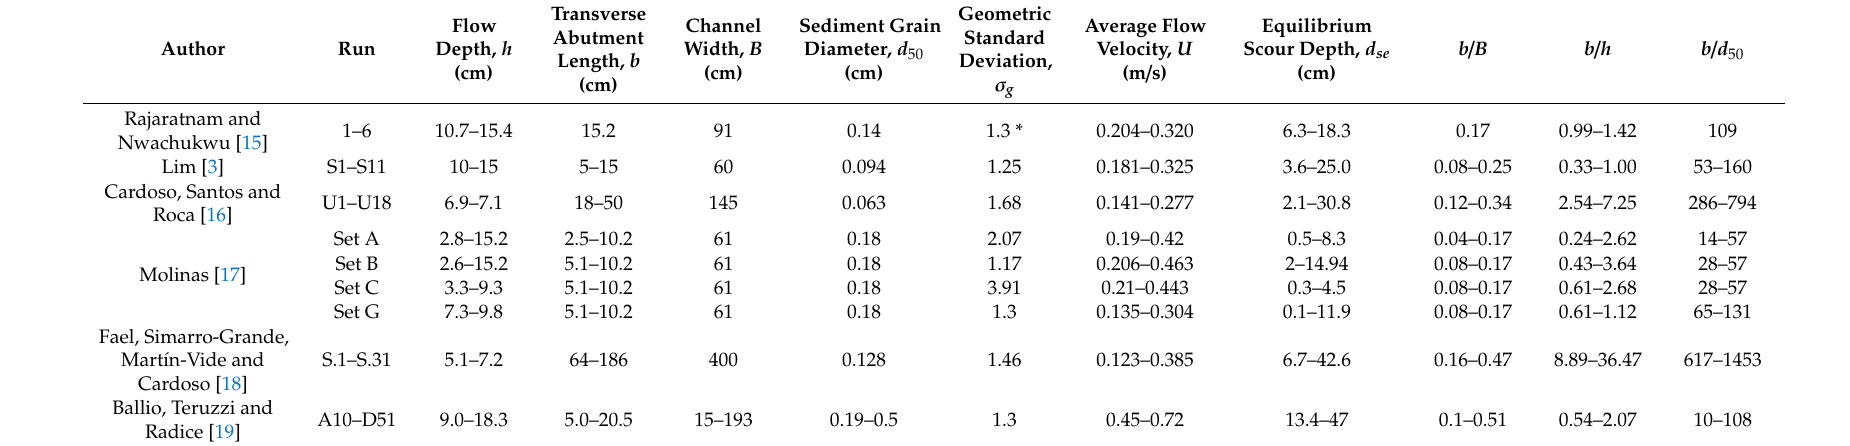
Table 2. Compilation of experimental